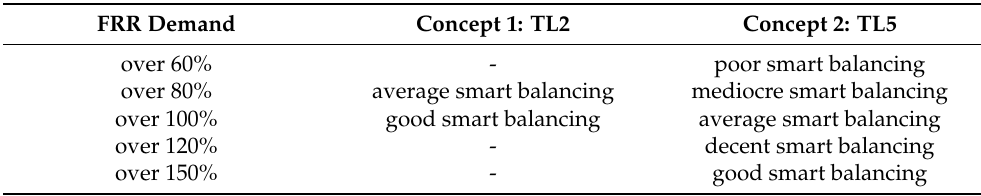
Table 3. Traffic light concepts depending on demand of contracted automatic and manual Frequency Restoration Reserves